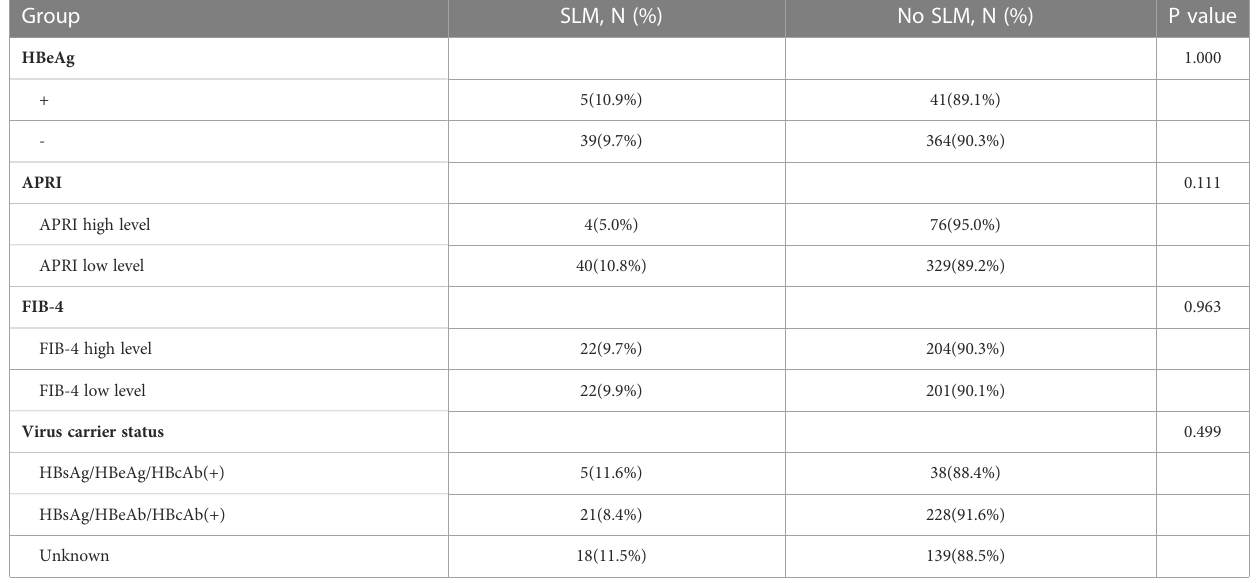
TABLE 3 Effect of e-antigen, liver cirrhosis, and virus carrier status on CRLM in HBsAg(+) group. Group